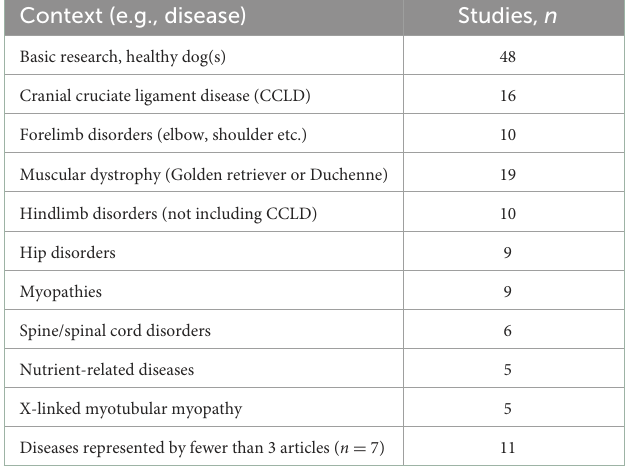
TABLE 2 Unfolding the method category “scoring systems” including 24 studies (XLMTM: X-linked myotubular myopathy).